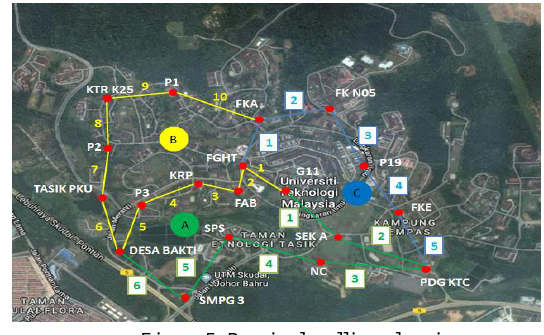
Figure 5. Precise levelling planning